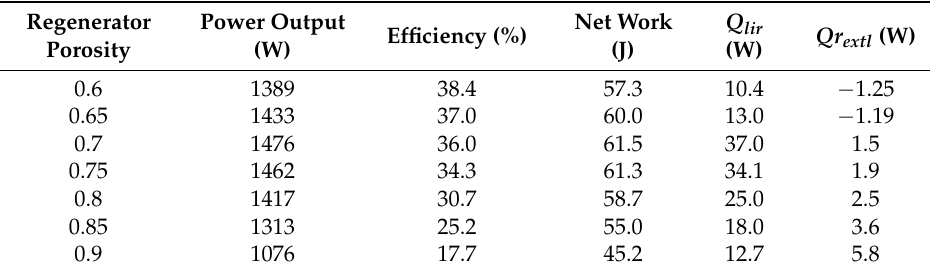
Table 8. Influence of regenerator